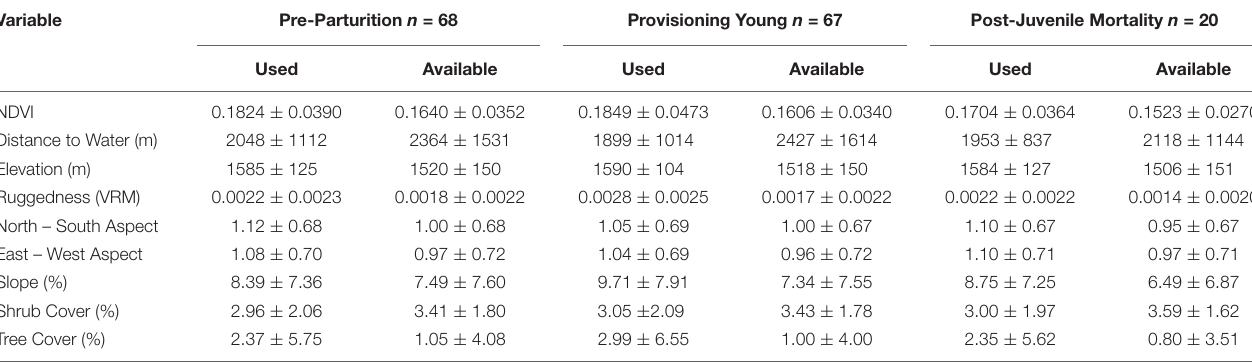
TABLE 1 | Descriptive statistics (mean ± SD) of available (random) and used (mule deer locations) data points for individuals in each reproductive time period on the Mojave National Preserve, California, United States, 2013–2016. Variable Pre-Parturition n = 68 Used Available Used Available Used